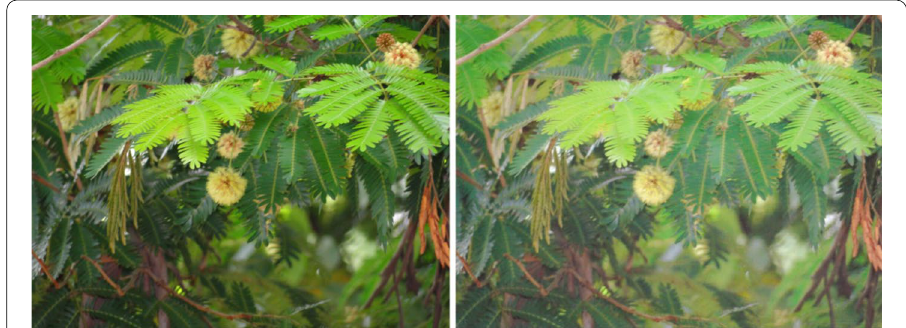
Fig. 2 Pristine image before (left) and after (right) printing and scanning on Xerox1 (Xerox Altalink C8070 Multifunction Printer). We note that there is significant variation between the two images, similar to that introduced by the global manipulation methods with which we experimented